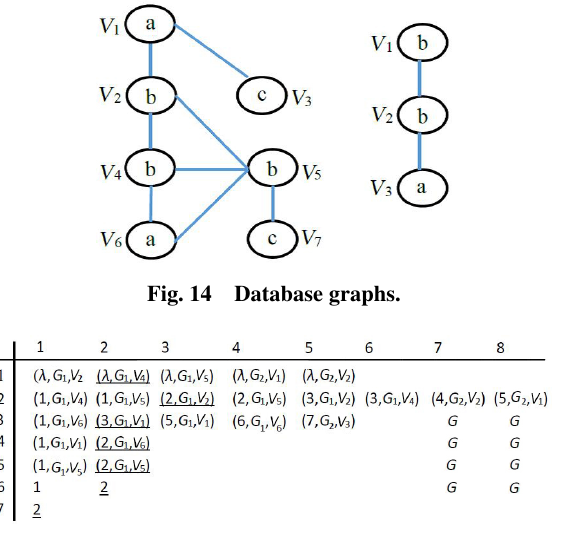
Fig. 15 Embedding. Fig. 16 An ADI structure [45]